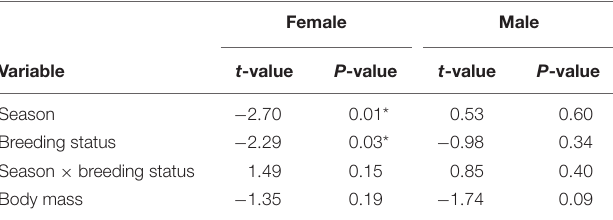
TABLE 2 | The statistical outputs of the effects of the season (non-breeding period/wet season vs. breeding period/dry season) and breeding status (breeding vs. non-breeding), their two-way interactions and body mass on the total antioxidant capacity (TAC) of 31 female and 35 male highveld mole-rats ( Cryptomys hottentotus pretoriae